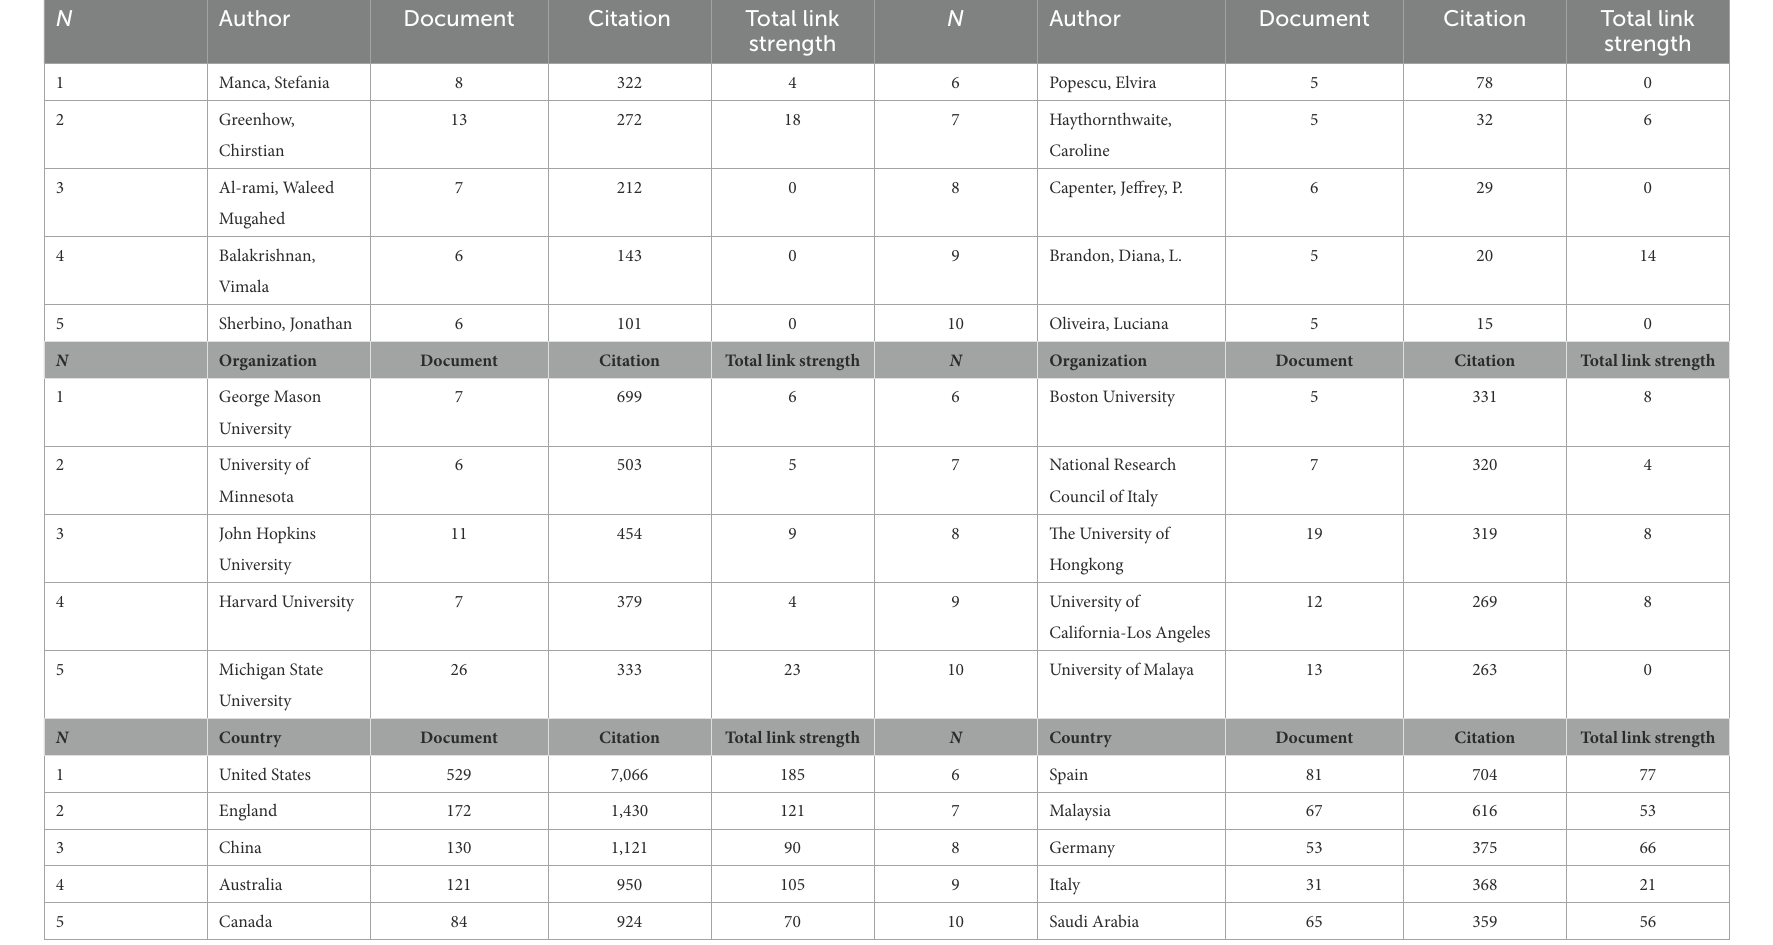
TABLE 3 Top 10 authors, organizations, and countries based on the